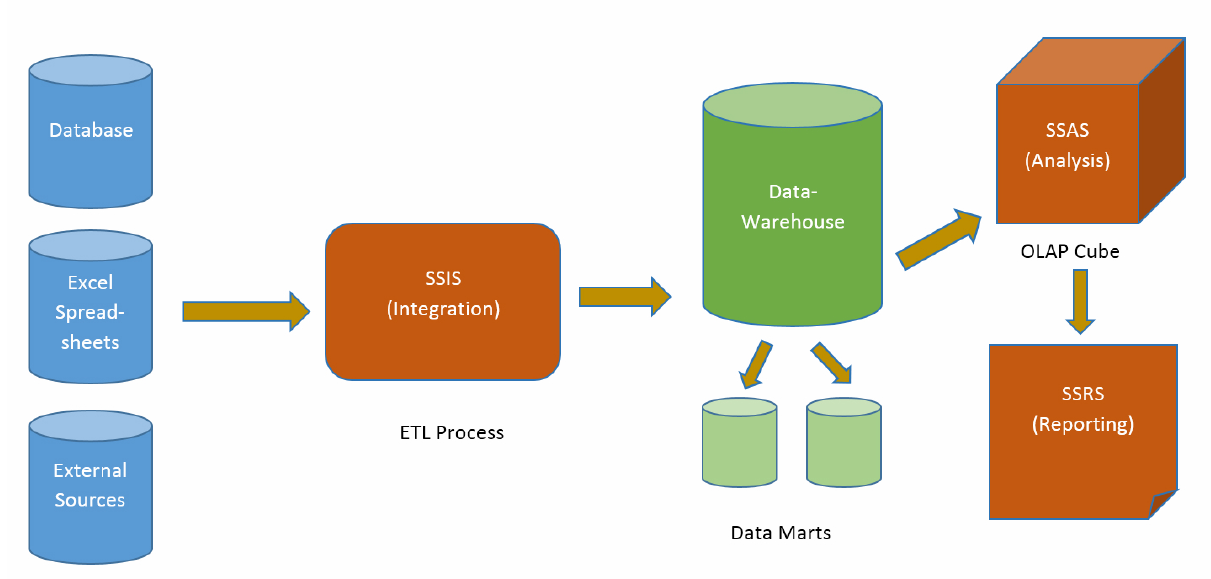
Figure 1. Business intelligence modeling